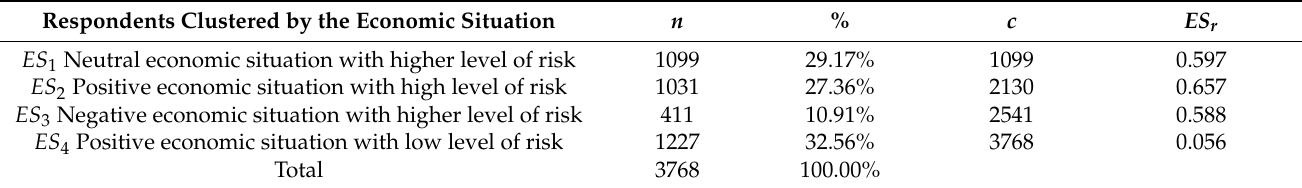
Table 3. Respondents belonging to economic situation types